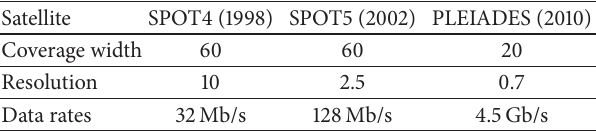
Table 1: Input date rates of compression system for France earth observation satellites in recent